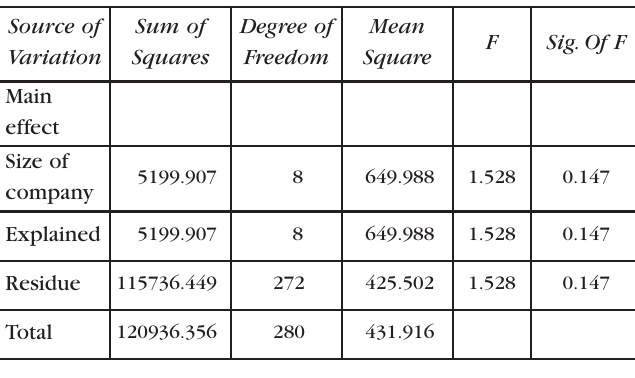
Table 1. ANOVA: Industrial Classifications as Categorical Variable and Size of Company by Number of Employees as Dependent